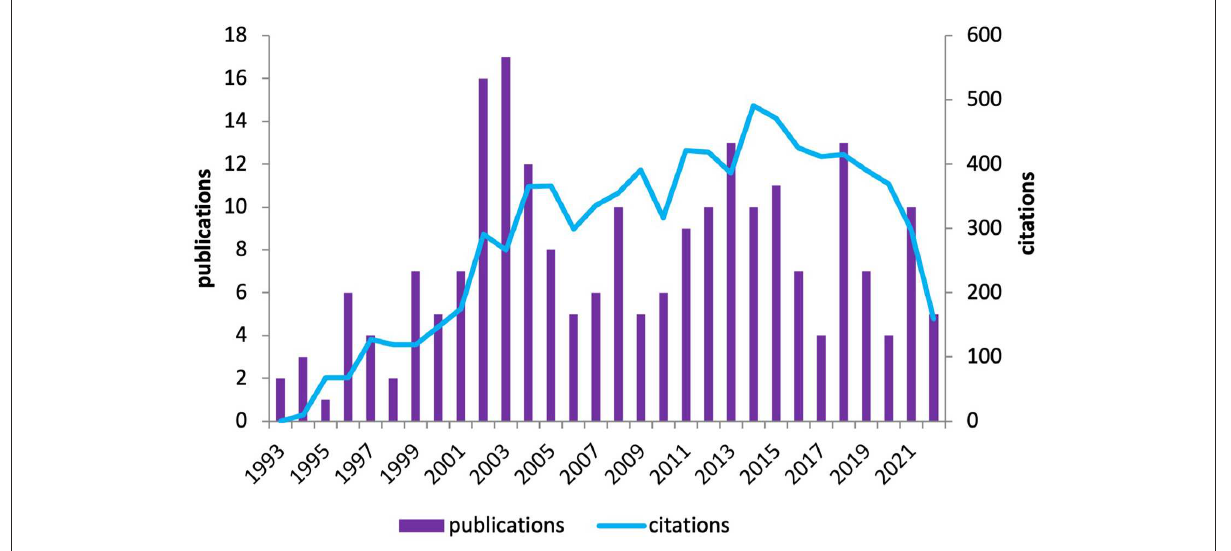
FIGURE1 Times cited and publications on TB molecular epidemiology over time.